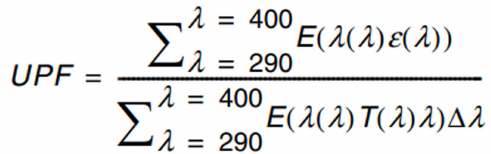
Figure 12. Equation for the calculation of the ultraviolet protection factor (UPF), where E( λ ) is the solar spectral irradiance; ε ( λ ) is the relative erythema effectiveness; T( λ ) is the spectral transmittance at wavelength; and ∆ λ is the wavelength interval of the measurements.